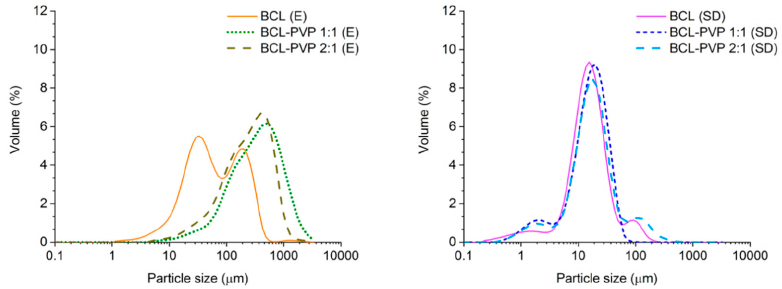
Figure 6. Particle size distribution of evaporated (E) and spray dried (SD) bicalutamide and BCL–PVP binary systems (1:1 and 2:1 weight ratio, respectively).